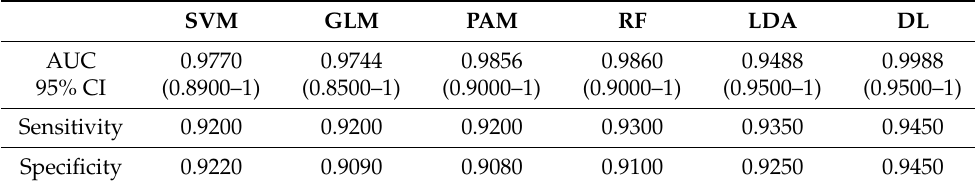
Table 3. Artificial Intelligence and circulating cfDNA prediction for the Alzheimer’s disease Extra- genic CpGs (20 Variables Bootstrapping–Independent Test group). SVM GLM PAM RF